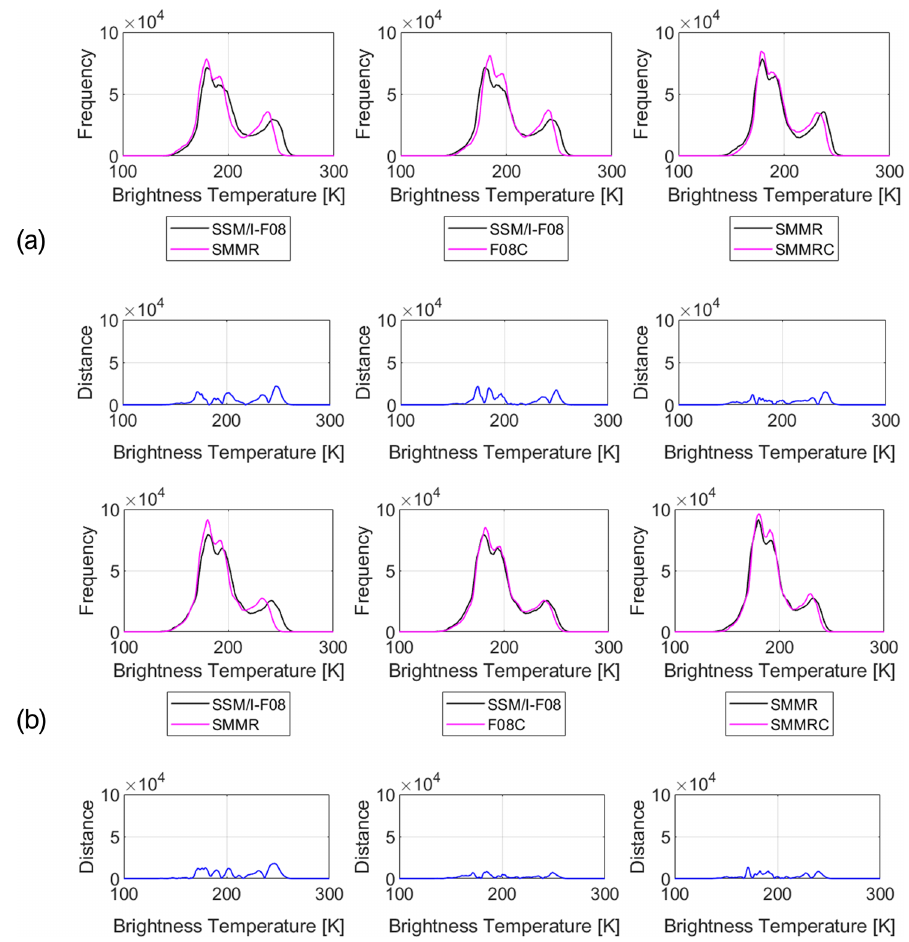
Figure 4. Histograms of T b before and after the application of the intercalibration relations (for Greenland). Relations are applied for both evening (a) and morning (b) passes, and the histograms of the data and the distance (absolute value of the difference as in Eq. 8) between the histograms for original data are reported. The left column represents the uncorrected data, the central column represents the results applying the correction to SMMR data and the right column represents the results applying the correction to the SSM/I